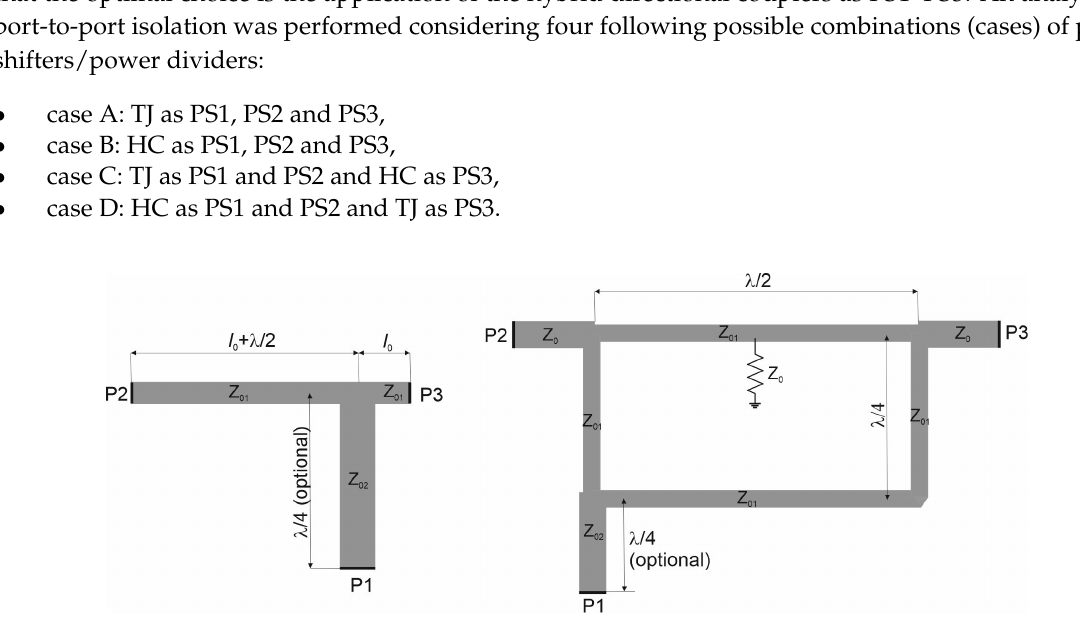
Figure 7. T-junction with half-wave section of transmission line (TJ) and hybrid directional coupler